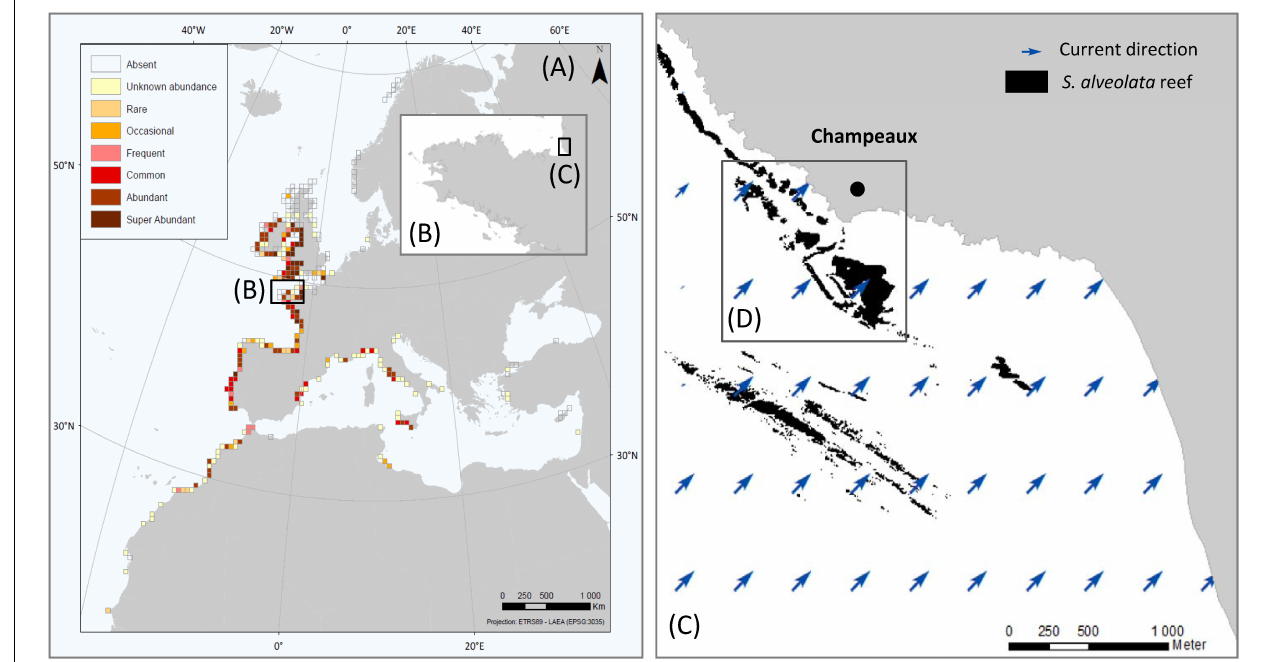
FIGURE 1 | Global distribution and abundance of S. alveolata (from Curd et al., 2020) (A) , Brittany region (B) , Eastern part of Mont-Saint-Michel bay (C) and study site showing S. alveolata existing map (from Basuyaux and Lecornu, 2015) (D).